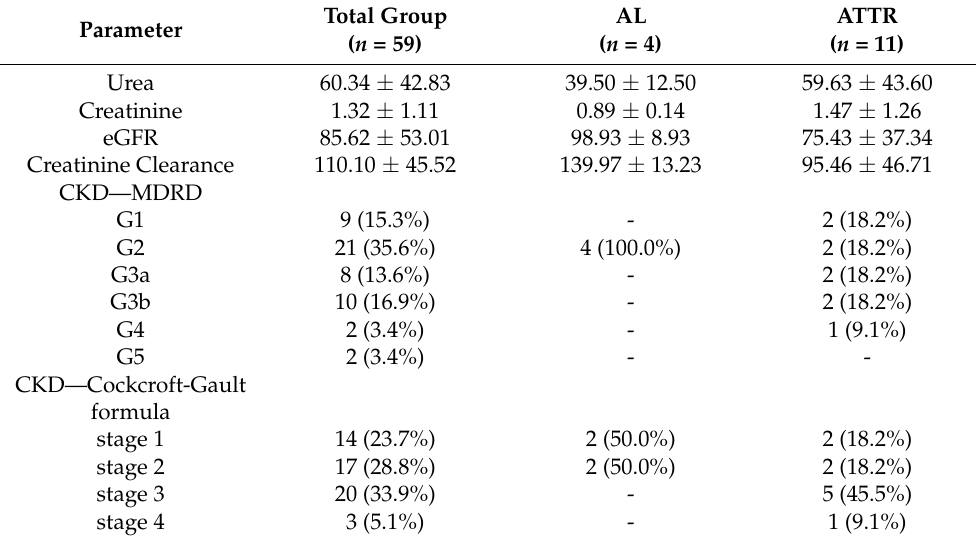
Table 15. Statistical representation of urea and creatinine levels for ATTR and AL positive patients. Parameter